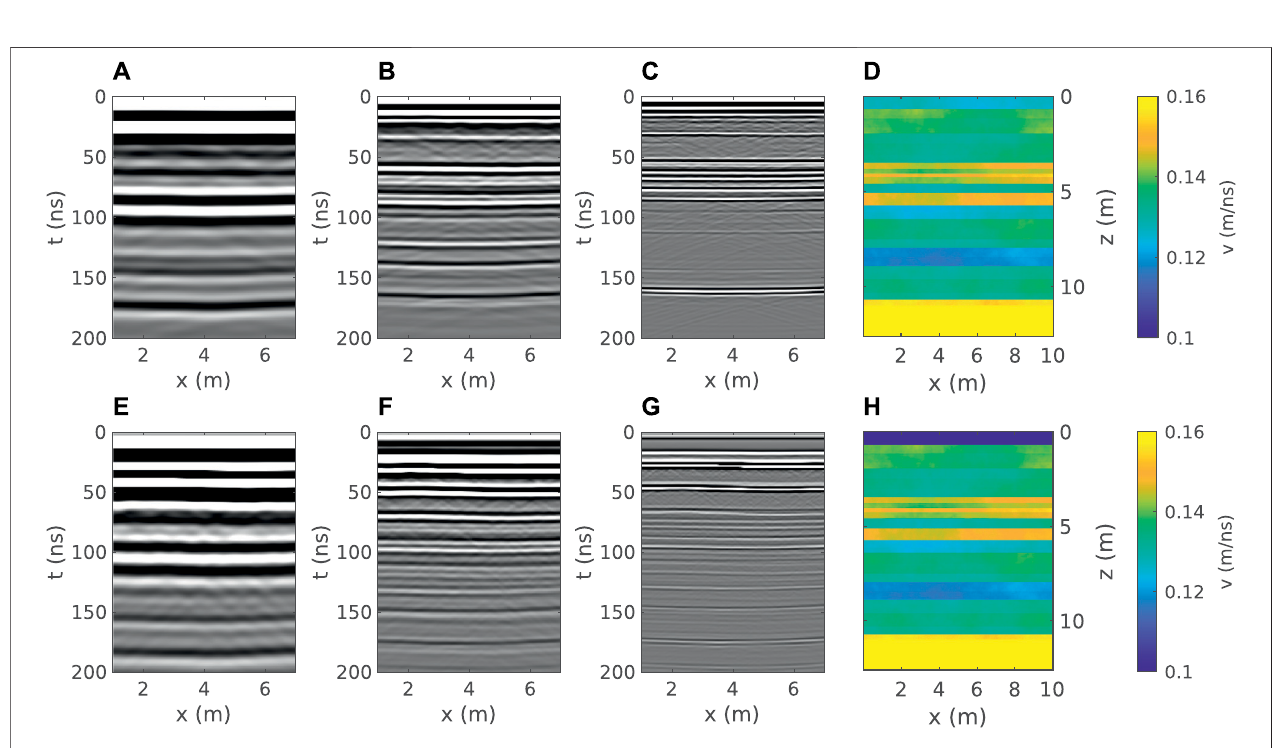
FIGURE 11 | Finite-difference time-domain modeling results for our 2D velocity model for 50 MHz (A,E) , 100 MHz (B,F) , and 200 MHz (C,G) for spring and summer scenarios, respectively. The corresponding velocity models are shown in (D) and (H) . Both models differ only in the uppermost 60 cm (active layer).